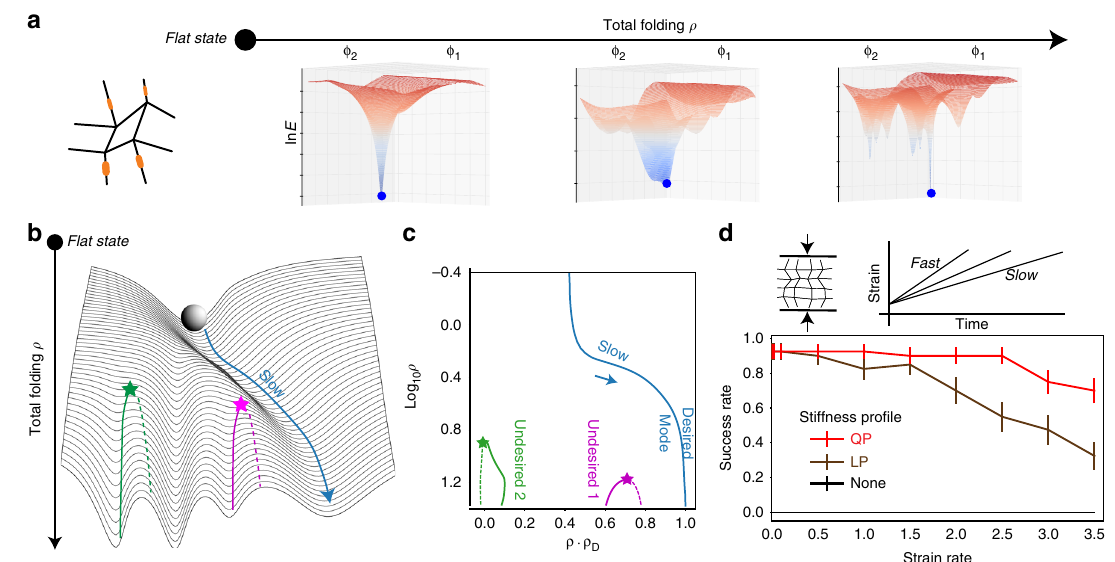
Fig. 3 Stiff creases change the topological connectivity of undesired modes and promote folding at slow speeds. a The energy landscape of a quad with stiff creases has a unique mode at low strain ρ , but becomes more complex at higher strain. b However, slow folding will recover the desired state provided the unique mode at low strain is continuously connected to the desired state and does not undergo a saddle-node bifurcation (blue line). Slow folding can be successful even if the unique mode at small strain ρ is quite distorted relative to the desired mode. c Bifurcation diagram as a function of total folding ρ for a speci fi c 16-vertex pattern shows select undesired modes (solid lines) being eliminated at bifurcations with saddles (dashed lines). Only the desired mode (blue) survives — albeit distorted — to the fl at state. d Simulations of folding at a fi nite strain rate (relative to relaxation timescale of hinges) show high success for slow folding and failures at higher folding speeds (Data from 50 random 16 − vertex